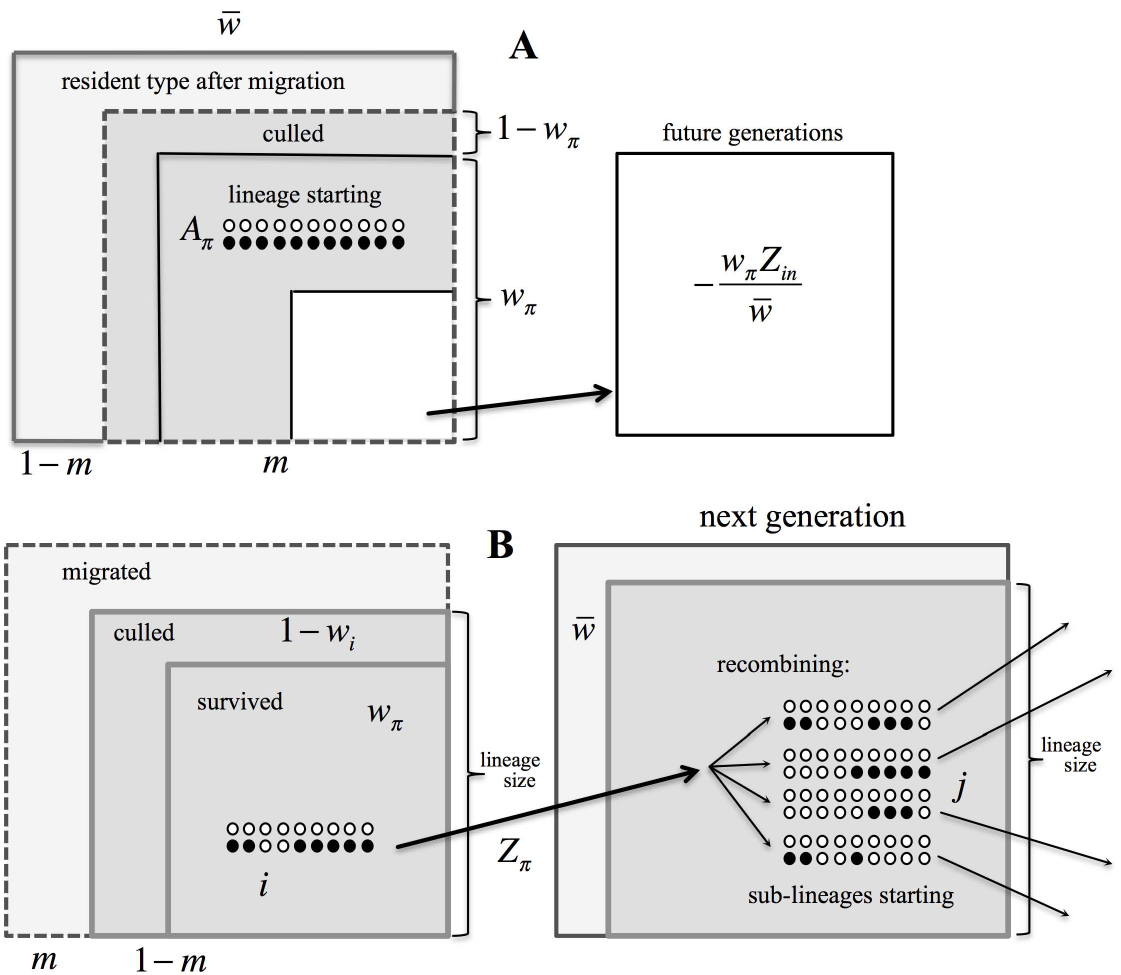
Figure 8. Schematic representation of the terms in Eqs (1) and (2). A – representing the mean population fitness from the branching process within foreign lineages. The future load caused by the independent lineages (white contour) is subtracted from the fitness contribution of the migrants, measured at the generation of sampling (contour filled by dark grey). Note that the proportion of migrants culled before reproduction, m 1 { w p ð Þ , is not a part of the mean population fitness. B – Dynamics of the lineage size, Z i , determined by the Eq. (2). Z i is reduced by migration and selection, but increased as the foreign genotype recombines and gives rise to sub-lineages. Note that the term 1 { m ð Þ 1 { w i ð Þ , i.e. the contribution of the individuals culled by selection, is included in the lineage size